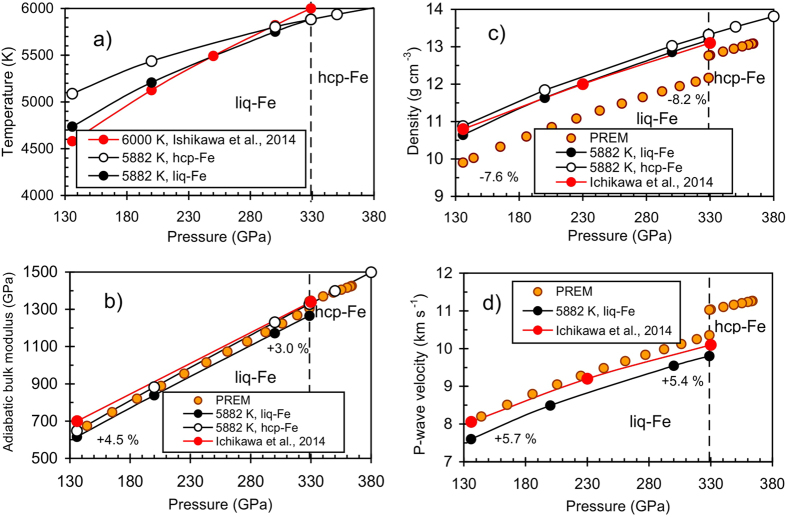
Comparison of the physical properties of liquid and hcp-iron calculated along an isentropic temperature profile (TICB = 5882 K) with the PREM72 and reference data95 (TICB = 6000 K).(a) Calculated isentropic temperature profile started from 5882 K at 328.9 GPa for liquid and hcp-iron compared with the reference data95 (b) Calculated adiabatic bulk modulus along adiabats for solid and liquid iron. (c) Calculated density along the 5882 K isentrope. (d) Calculated P-wave velocity along the isentrope.